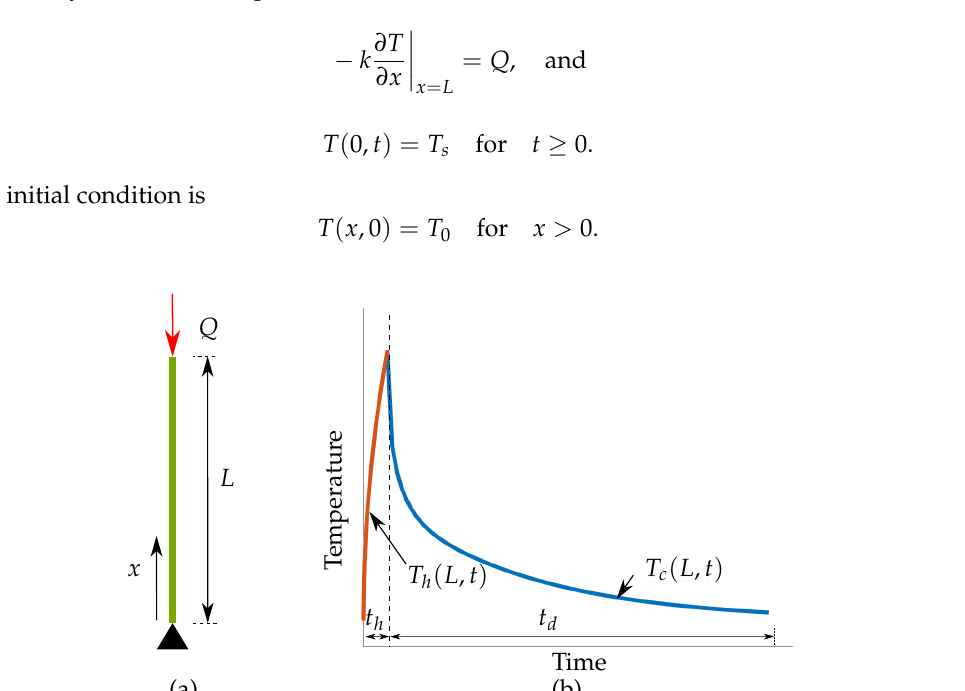
Figure 7. ( a ) one-dimensional domain with length L subjected to boundary conditions reminiscent to the reference model, i.e., heat flux Q acts at x = L while bottom temperature is fixed at T = T s . ( b ) Thermal history of the topmost point ( x = L ) of the rod during a heating and cooling